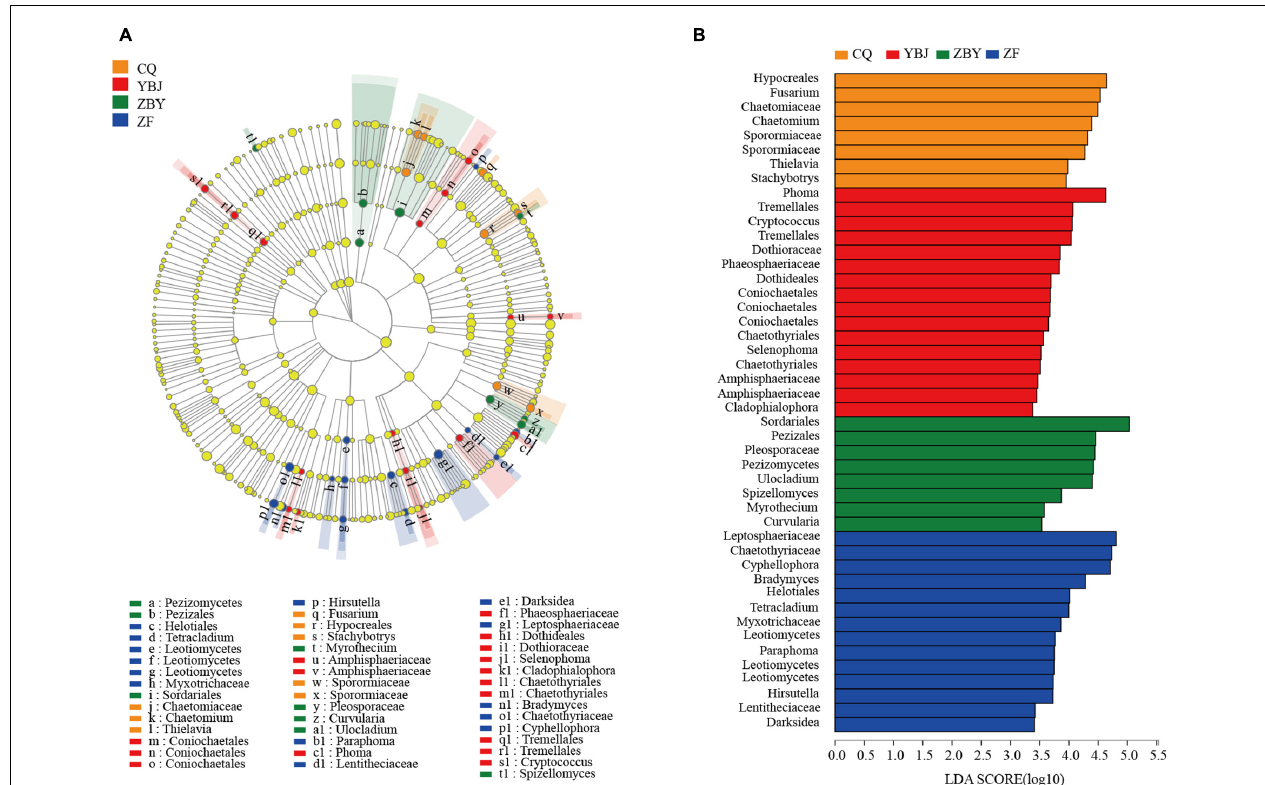
FIGURE 3 | LEfSe multilevel species hierarchy tree diagram and Latent Dirichlet Allocation(LDA) discrimination result diagram. (A) LEfSe multilevel species hierarchy tree diagram. (B) LDA discriminant result graph. The LDA discriminant column chart counts the microbial groups with significant effects in the four groups. The larger the LDA score is, the greater the impact of species abundance on the difference